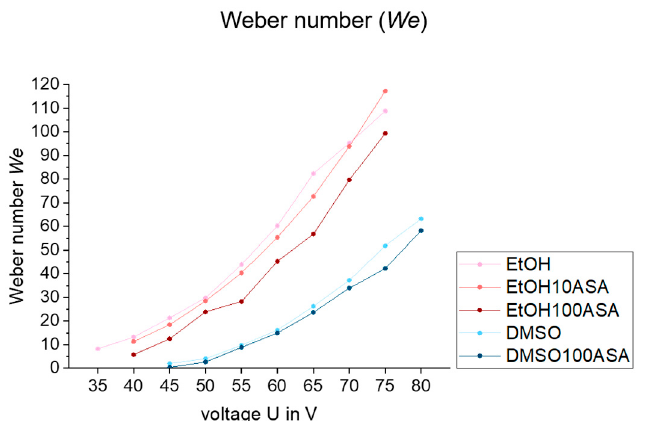
Figure 5. Plot of Weber number We over voltage for all investigated drug solutions as well as the pure solvents. A We < 40 is required to avoid splashing when droplets hit (wetted) substrates [32]. This We value can be achieved for all drug solutions if a suitable voltage is selected.